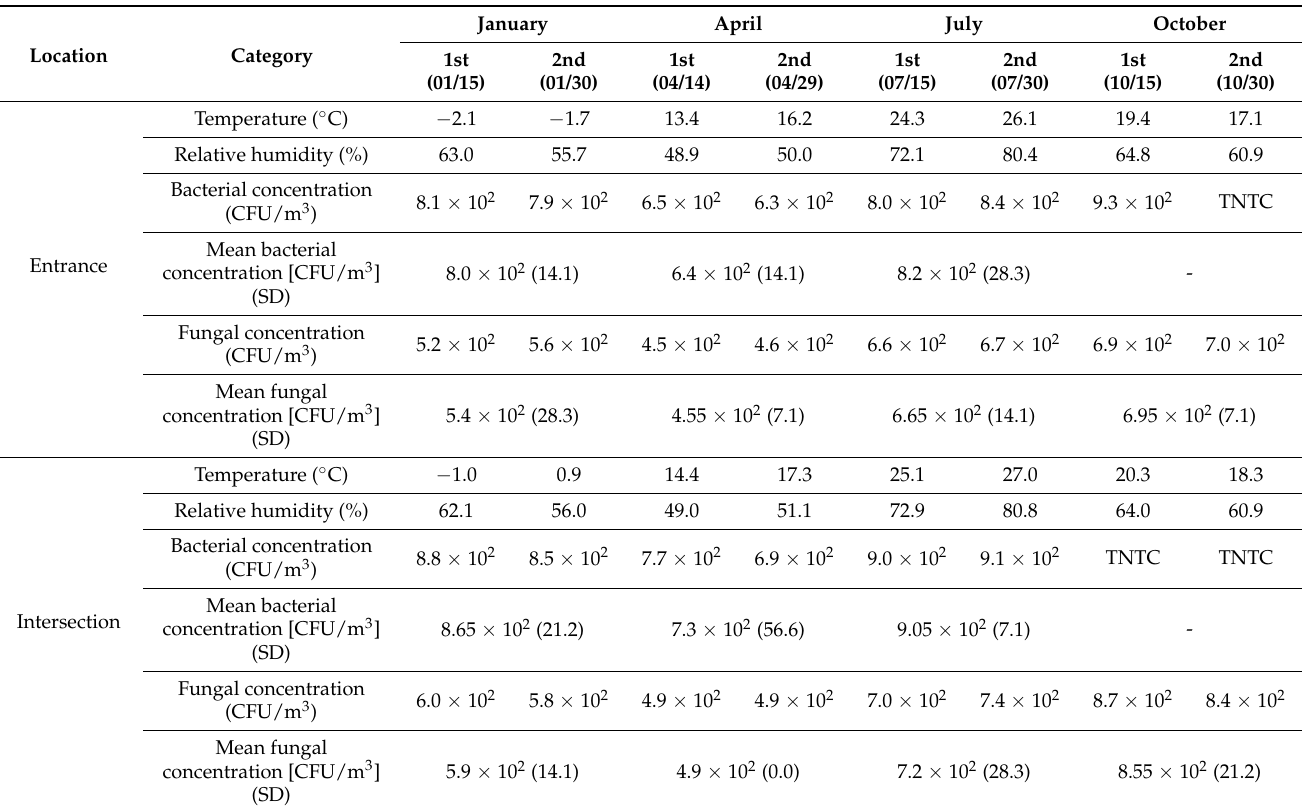
Table 2. Concentrations of different airborne microorganisms at “J”